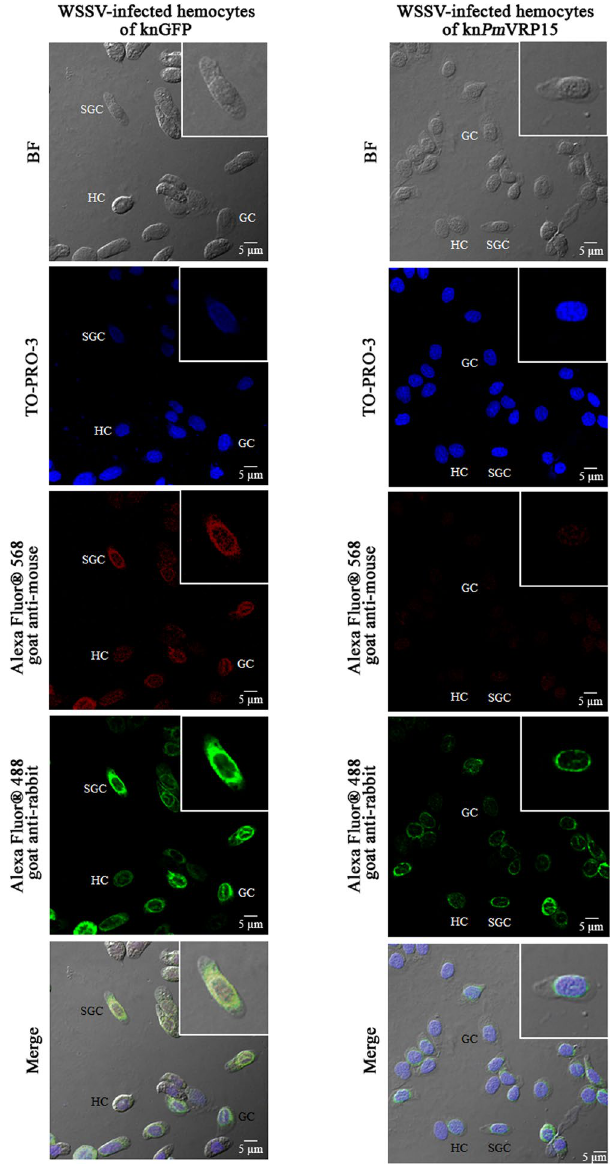
Figure 7. Immunofluorescent staining analysis of Pm VRP15 and VP28 in the WSSV-infected Pm VRP15- silenced hemocytes by confocal laser scanning microscopy. Hemocytes from Pm VRP15-silenced and GFP- silenced shrimp, infected by WSSV were collected at 48 hpi and probed by anti- Pm VRP15 and anti-VP28 antibodies. Pm VRP15 and VP28 proteins were visualized by secondary antibodies conjugated with Alexa Fluor ® 488 (green) and Alexa Fluor ® 568 (red), respectively. Nuclei were stained in blue. The GC, SGC and HC are granular, semigranular and hyaline cells, respectively. BFs are bright field